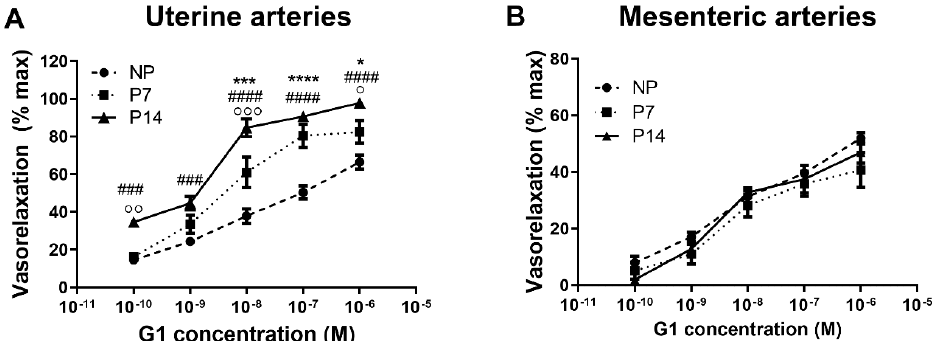
Figure 2. Pregnancy modulates concentration–responses to G1 in uterine arteries. In uterine arteries